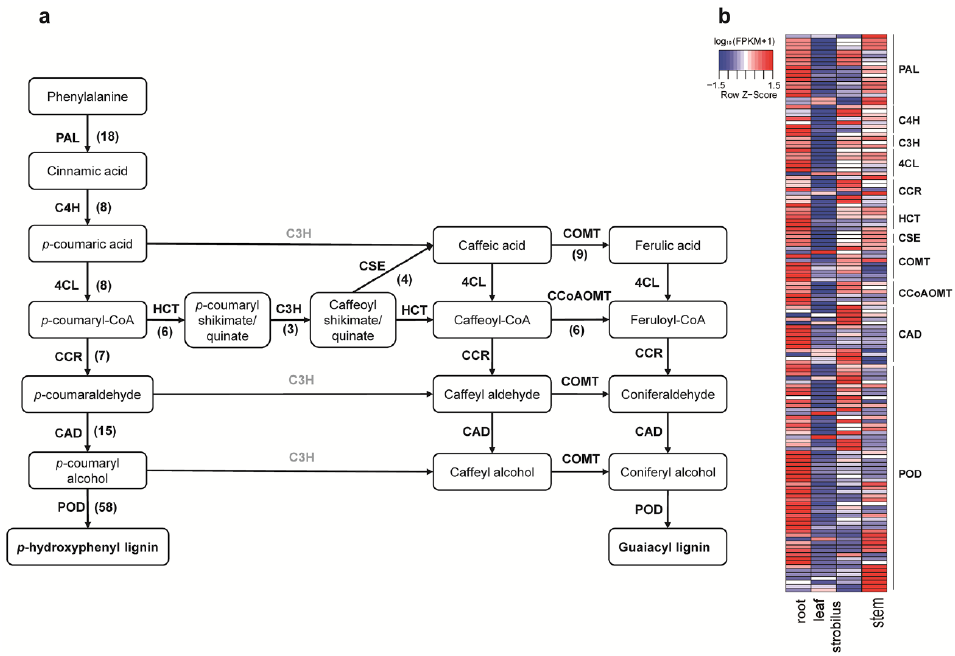
Figure 9. Biosynthesis pathway of phenylpropanoid in P. chienii and the differentially expressed genes (DEGs) involved in phenylpropanoid biosynthesis in four organs of P. chienii . ( a ) A simplified diagram of the phenylpropanoid biosynthetic pathway. Numbers in brackets represent DEG